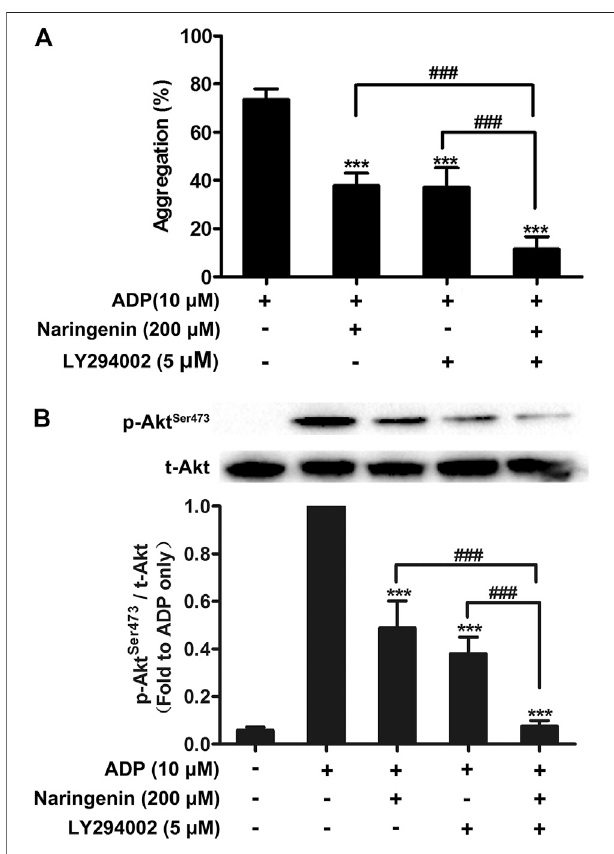
FIGURE 5 | Effects of naringenin combined with PI3K pan inhibitor LY294002 on platelet aggregation and Akt phosphorylation. Washed rat platelets were preincubated with naringenin (200 μ mol/L) alone, the PI3K pan inhibitor LY294002 (5 μ mol/L) alone or both for 5 min prior to ADP (10 μ mol/L) activation. After stimulation with ADP, platelet aggregation was quanti fi ed and expressed as a percentage (A) . Data are expressed as means ± SD ( n (cid:2) 6). *** p < 0.001 compared with the ADP-treated group, ### p < 0.001 compared with naringenin alone or LY294002 alone. Platelet proteins were then extracted and speci fi c antibodies were used to measure the level of total and phosphorylated Akt (B) . The blots shown are representative of three separate experiments. The relative protein expression levels were quanti fi ed by ImageJ 1.47v software. The level of phosphorylation obtained in the ADP-treated group was taken as 1. Data are expressed as means ± SD ( n (cid:2) 3). *** p < 0.001 compared with the ADP-treated group, ### p < 0.001 compared with naringenin alone or LY294002